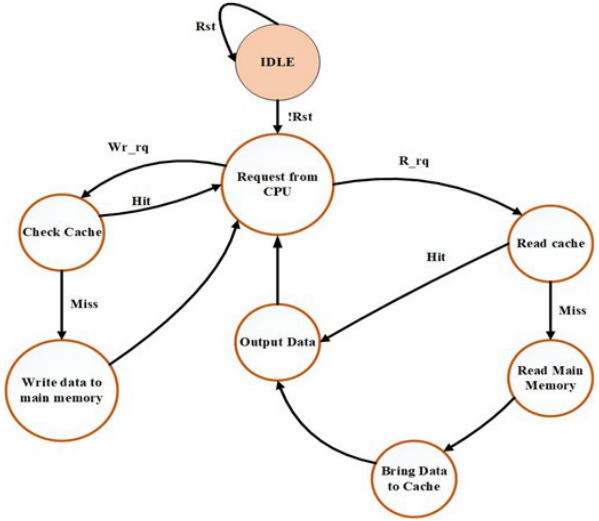
Figure 5. FSM of cache system for read and write request.